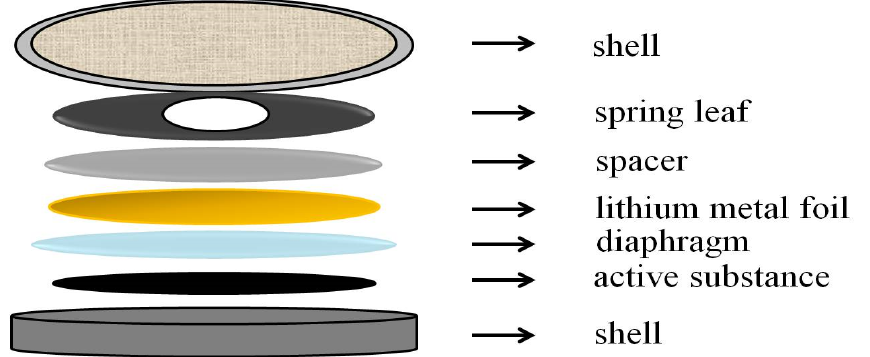
Figure 1. The diagram of the cell configuration.